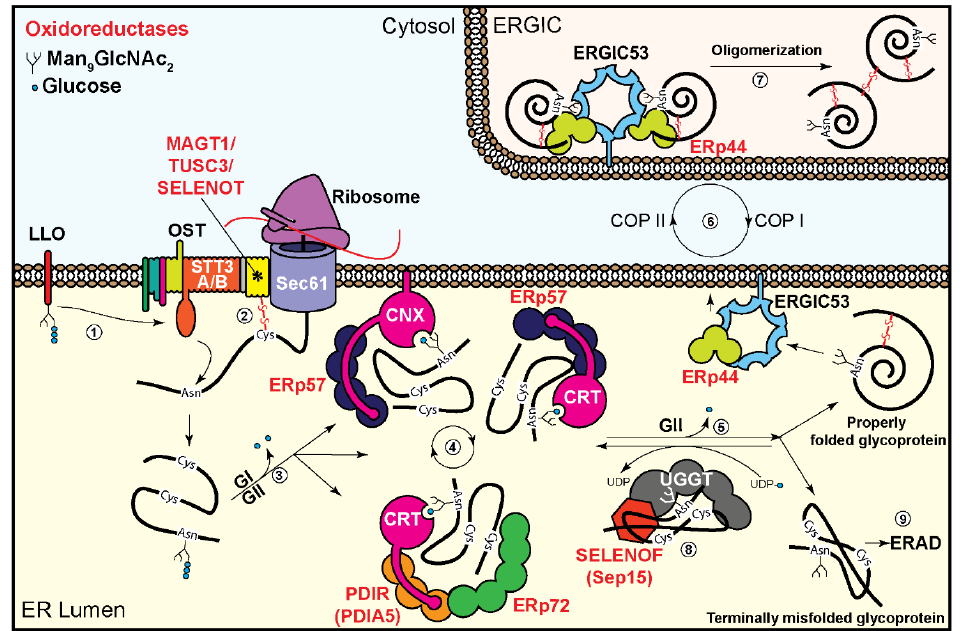
Figure 1. Glycoprotein translocation and folding in the endoplasmic reticulum (ER) in mammalian cells. (1) The oligosaccharide transferase (OST) complex co-translationally transfers the N-glycan precursor (Glc 3 Man 9 GlcNAc 2 ) from the lipid-linked oligosaccharide (LLO) (Glc 3 Man 9 GlcNAc 2 -PP-Dolichol) to an asparagine residue in an N-glycosylation sequon of the glycoprotein during its translocation into the ER. (2) Sugar chain transfer to the glycoprotein is assisted by mixed disulfide bond formation between the glycoprotein and MAGT1 (IAP) or TUSC3 (N33) (in complex with the catalytic OST subunit STT3B), or with selenoprotein T (SELENOT) (in complex with the catalytic OST subunit STT3A). The names of other subunits of the large OST complex are omitted for simplicity. (3) The two terminal glucose residues are removed by Glucosidase I and II (GI and GII), respectively, allowing the glycoprotein to enter folding cycles by the ER chaperones calnexin (CNX) and calreticulin (CRT). (4) The oxidoreductase ERp57 interacts with CNX and CRT, assisting disulfide bond formation. Similar activity is observed by ERp72 indirectly interacting with CRT via PDIR. (5) The removal of the last glucose residue by GII results in the exit of the glycoprotein from the CNX cycle. (6) Properly folded glycoproteins are sent to the Golgi via the ER–Golgi intermediate compartment (ERGIC), mediated by a complex of ERGIC-53 and the oxidoreductase ERp44. (7) The ERGIC53/ERp44 complex is shuttled via COPII vesicles to the ERGIC, where it aids glycoprotein oligomerization. Unassembled subunits are shuttled back to the ER with ERp44 via COPI vesicles. (8) Misfolded glycoproteins are retained in the ER, where they are recognized by UDPGlc:glycoprotein glucosyltransferase (UGGT), with its 4 inactive Trxl domains in a complex with the seleno-oxidoreductase Sep15. UGGT reglucosylates the glycoprotein for re-entry into the CNX folding cycle. (9) Terminally misfolded glycoproteins are targeted to ER-associated degradation (ERAD). Oxidoreductases are marked in red.